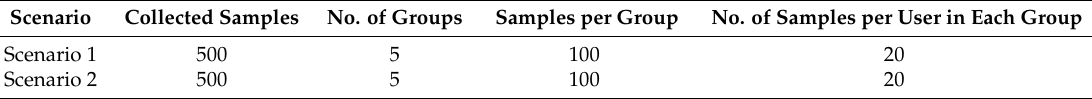
Table 2. Collected samples of each activity in each